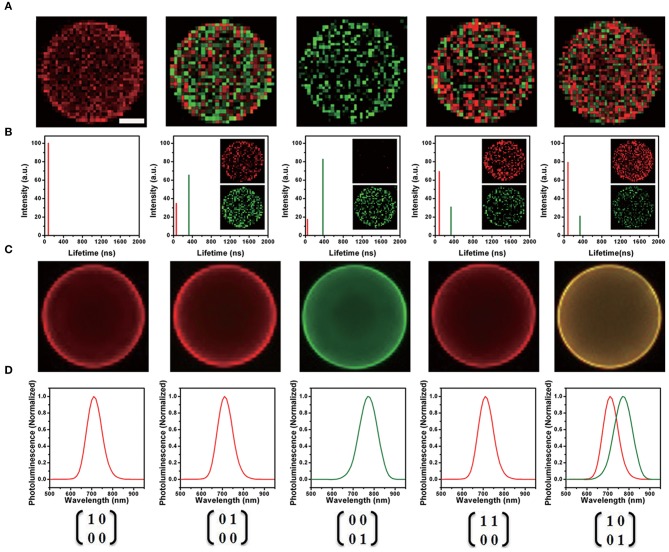
(A) Fluorescence lifetime imaging (FLIM) image of each near-infrared (NIR)-emitting 2D encoded microbeads. The scale bar indicates 10 μm, which is also applicable for (C). (B) Lifetime distribution of NIR-emitting 2D encoded microbeads (inset: unmixed FLIM image). (C) Merged fluorescence emission spectra image of each NIR emitting 2D encoded microbeads with multi-emission (pseudo-colored red: 700 nm; pseudo-colored green: 760 nm). (D) Fluorescence emission spectra of NIR-emitting 2D encoded microbeads (Chen et al., 2014). Reproduced with permission. Copyright 2014 John Wiley and Sons.